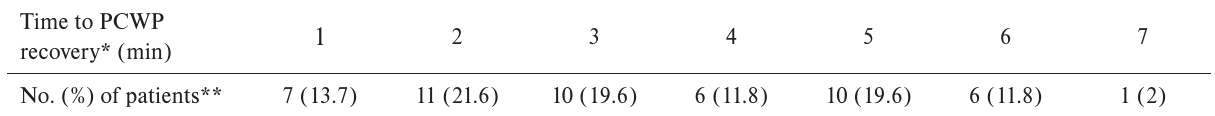
Table 3. Time to post-exercise pulmonary capillary wedge pressure recovery in individual